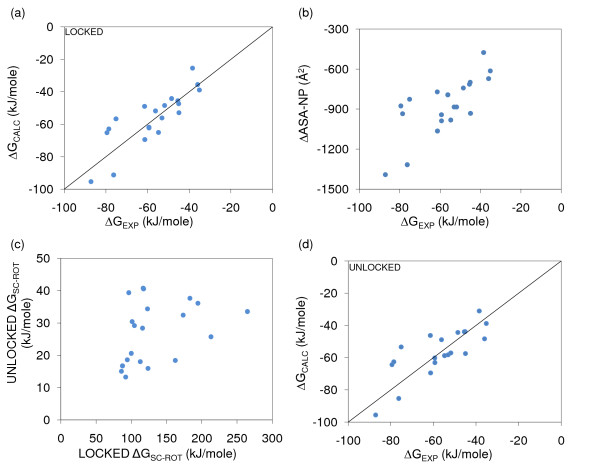
ΔG models with Locked and Unlocked interfacial sidechains, Minimal-HighSA. Binding models are fit to wild-type ΔGEXP, and Minimal-HighSA implies no repacking for wild-type systems. (a) Model fit with ΔGSC-ROT calculated for Locked interfacial sidechains and ΔGROT-TRANS = 0 (R2 = 0.69). (b) Correlation between ΔGEXP and Δ(ASA-NP) (R2 = 0.55). (c) Poor correlation (R2 = 0.12) between ΔGSC-ROT calculated with Locked and Unlocked interfacial sidechains. (d) Model fit with ΔGSC-ROT calculated for Locked interfacial sidechains and ΔGROT-TRANS = 0 (R2 = 0.61). For plots with equivalent y and x quantities, the line y = x is shown.